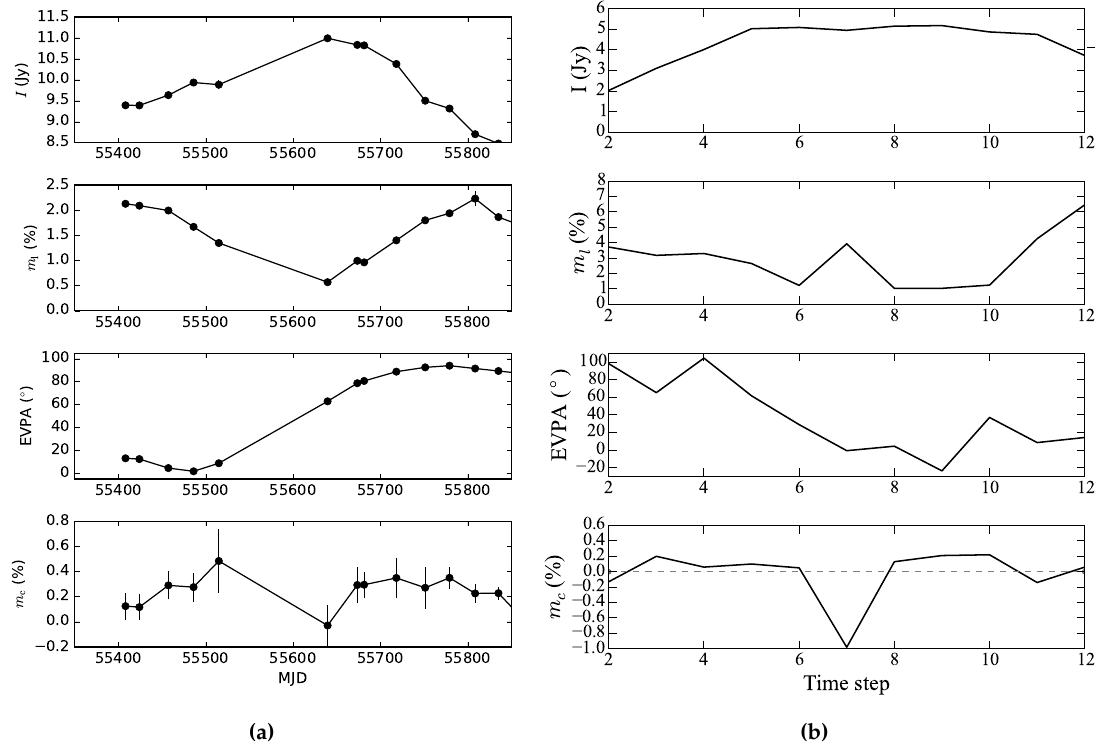
Figure 1. ( a ) The 8.35-GHz total flux density and polarization lightcurves of the blazar 3C454.3 for the MJD range of ∼ 55400 to ∼ 55800. From top to bottom: (1) Stokes I ; (2) the degree of linear polarization m l ; (3) the polarization angle (EVPA) and (4) the degree of circular polarization m c . ( b ) A reproduction of the 8.35-GHz total flux density and polarization variability (left). The synthetic full-Stokes lightcurves were generated by our